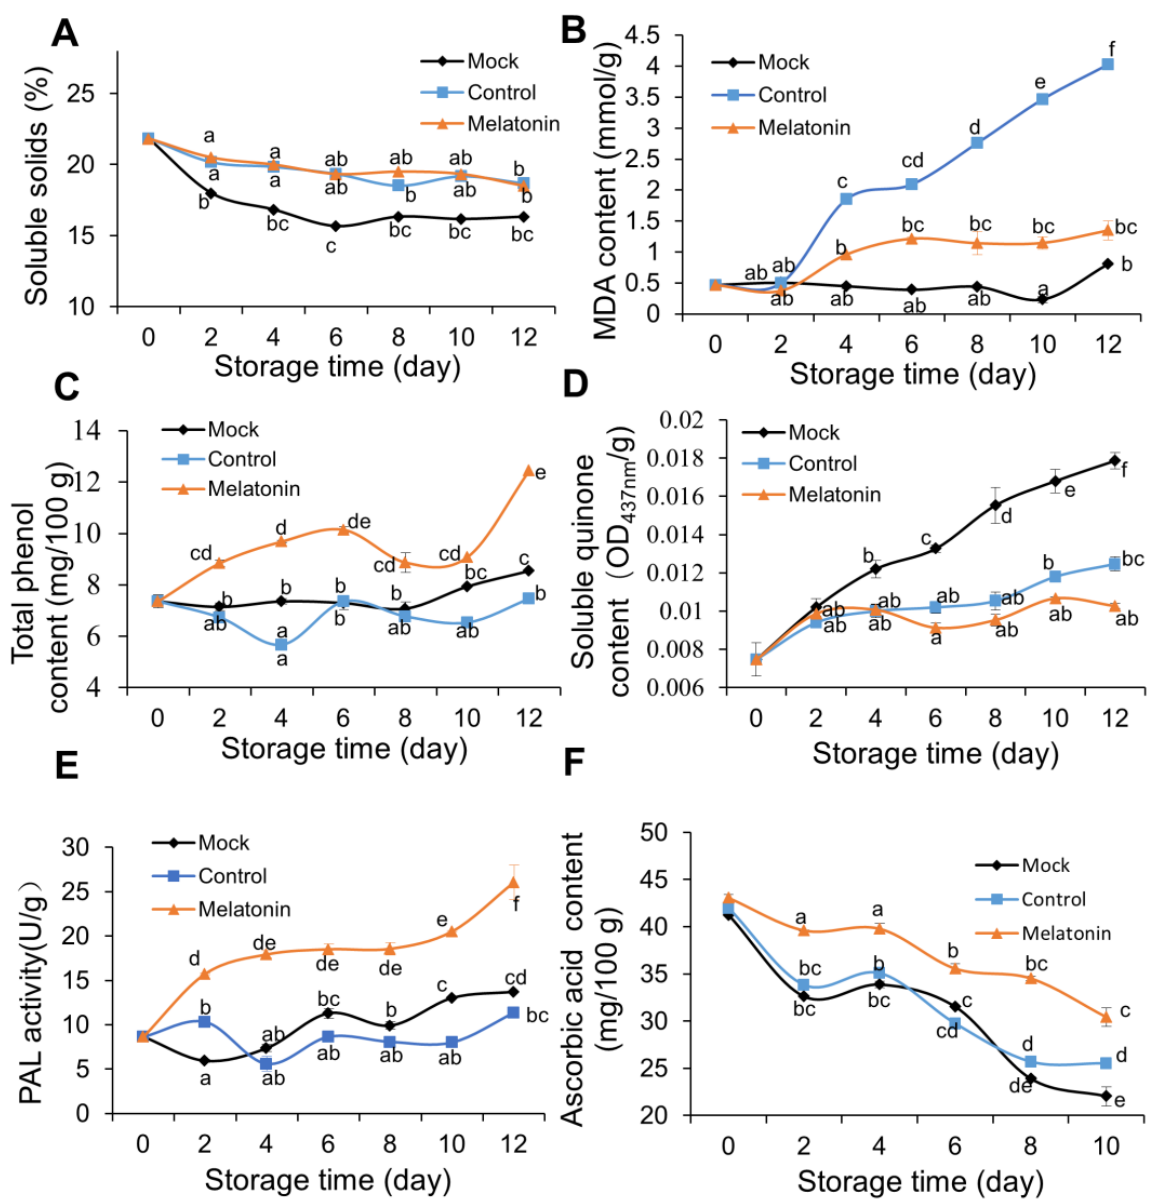
Figure 2. Effect of melatonin on the soluble solids ( A ), MDA content ( B ), total phenol content ( C ), soluble quinone gas concentration ( D ), PAL activity ( E ), and vitamin C content ( F ) of fresh-cut lotus roots (‘E Lian 5’). Fresh-cut lotus roots were treated with tap water (control, left triangle) or 40 mmol/L melatonin solution (MELATONIN, circles). Error bars represent SEs from three biological replicates. Different letters represent significant differences at p < 0.05 level.